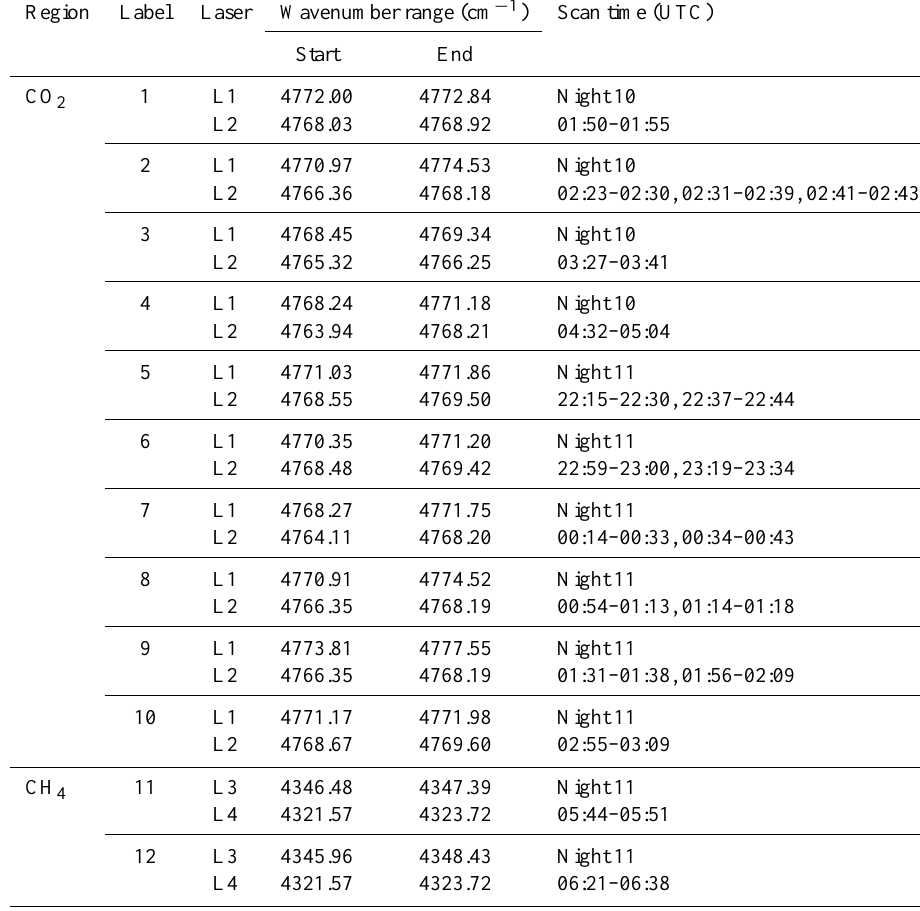
Table A2. Scans performed during the campaign. Region Label